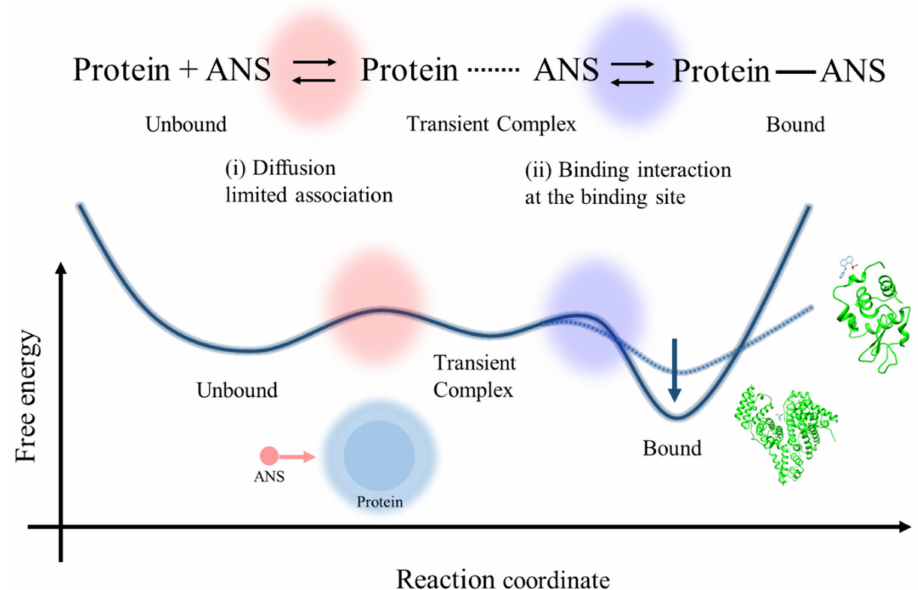
Figure 8. The proposed free energy surface of the ANS–protein binding with the kinetic scheme of the association between ANS and protein molecules via the formation of the transient